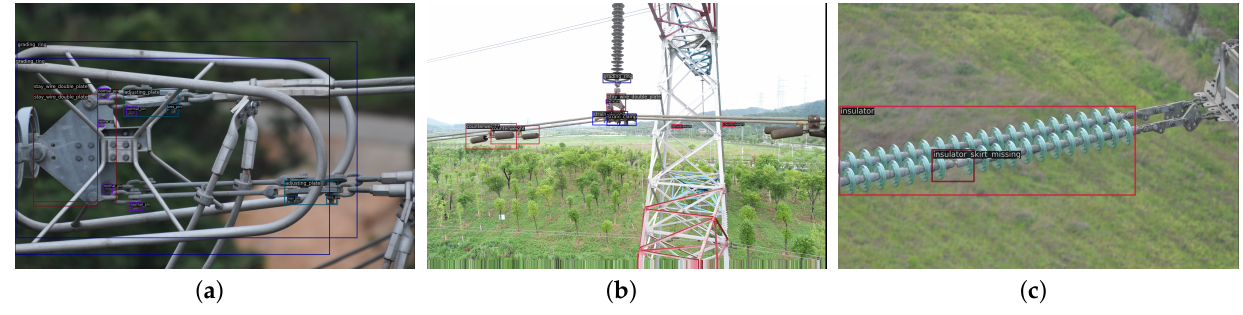
Figure 8. Typical object types in transmission line. ( a ) Scene of grading ring structure. ( b ) Scene of strain clamp structure. ( c ) Scene of insulator